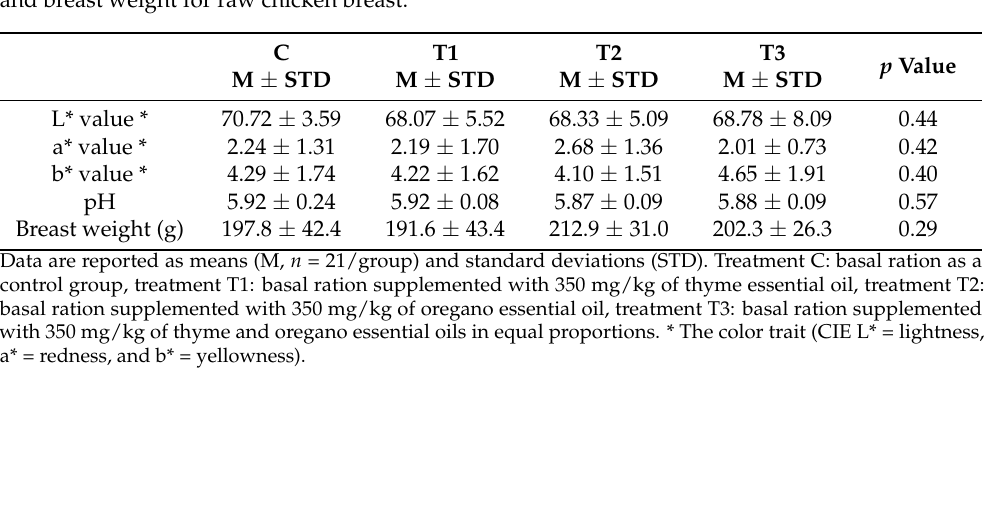
Table 3. The effects of the inclusion of thyme and oregano extracts on color traits (L*, a*, and b*), pH, and breast weight for raw chicken breast.